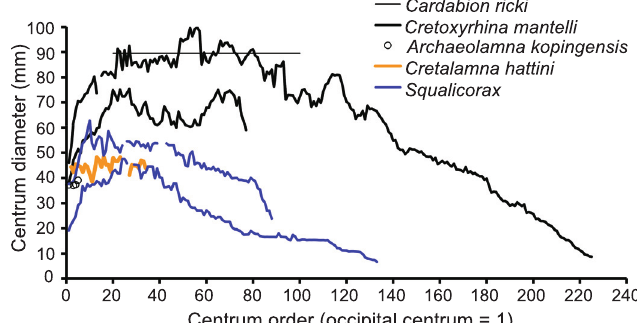
Fig. 6. Centrum size profiles of Cardabiodon ricki , Cretoxyrhina mantel- li , Cretalamna hattini , Archaeolamna kopingensis , and Squalicorax sp. Centrum diameter of Cardabiodon ricki (WAM 96.4.45.108) compared to those of other lamniforms: Ar. kopingensis (LACM P-128125), Cretoxy- rhina mantelli (FHSM VP-323, VP-2187), Cretalamna hattini (LACM P-128126), and Squalicorax (LACM P-120090; USNM 425665). Centrum sizes for Ar. kopingensis , Cretoxyrhina mantelli , and Squalicorax spp. are taken from Cook et al.